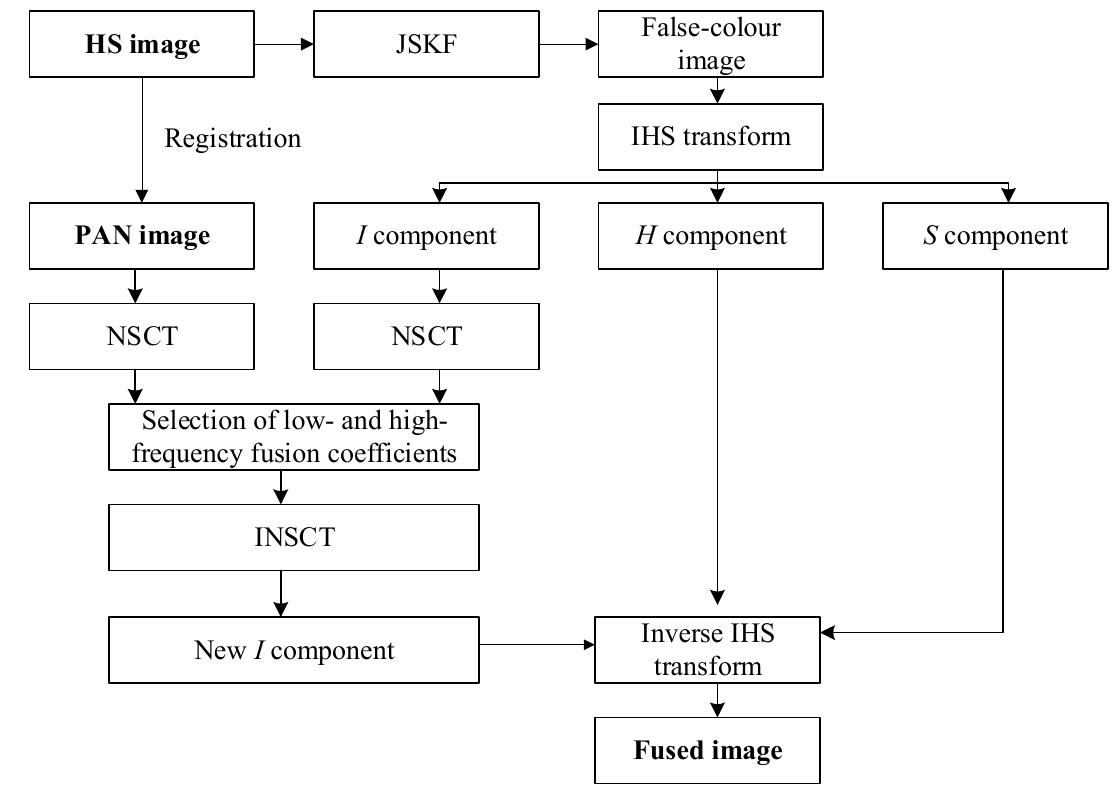
Figure 2. The overall technical flowchart of our proposed fusion algorithm.